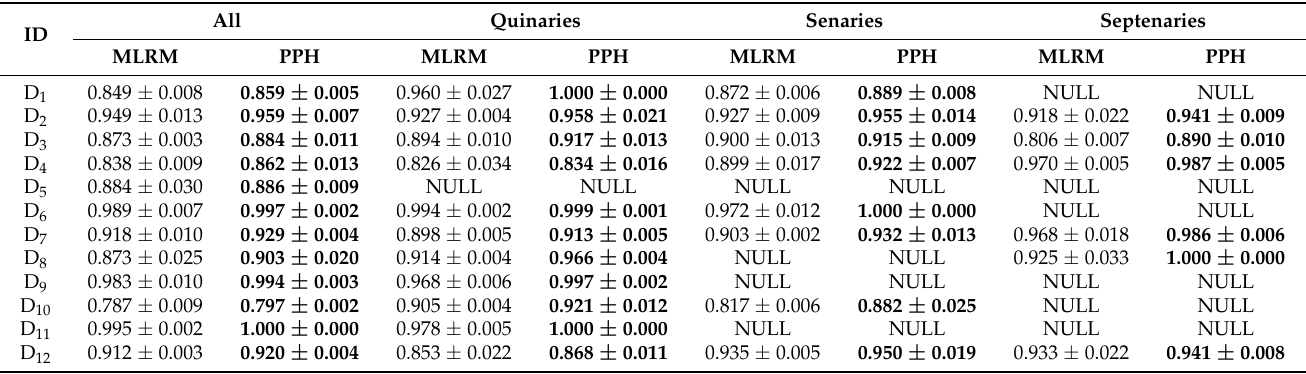
Table 15. Accuracy comparison between PPH and MLRM in all, quinaries, senaries, and septenaries.